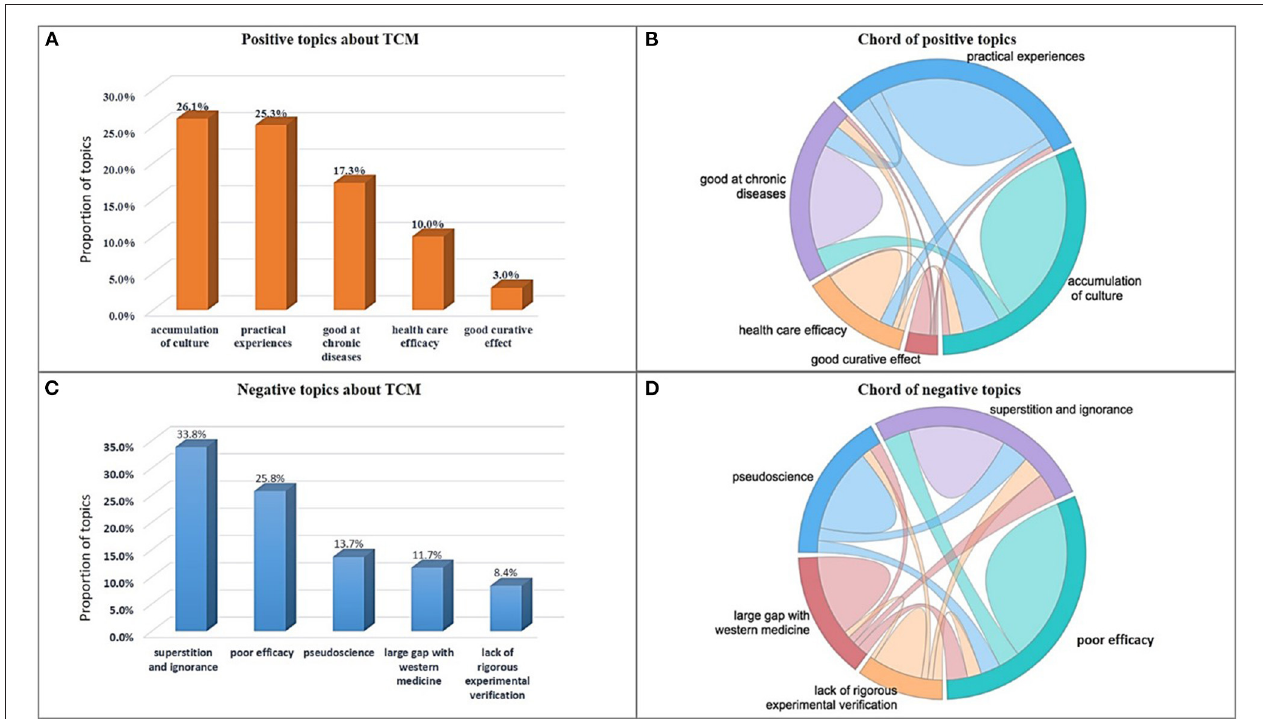
FIGURE 3 | The top five topics about TCM in cyberspace. (A) The top five positive topics. (B) The co-occurrence relationships between these five positive topics. (C) The top five negative topics. (D) The co-occurrence relationships between these five negative